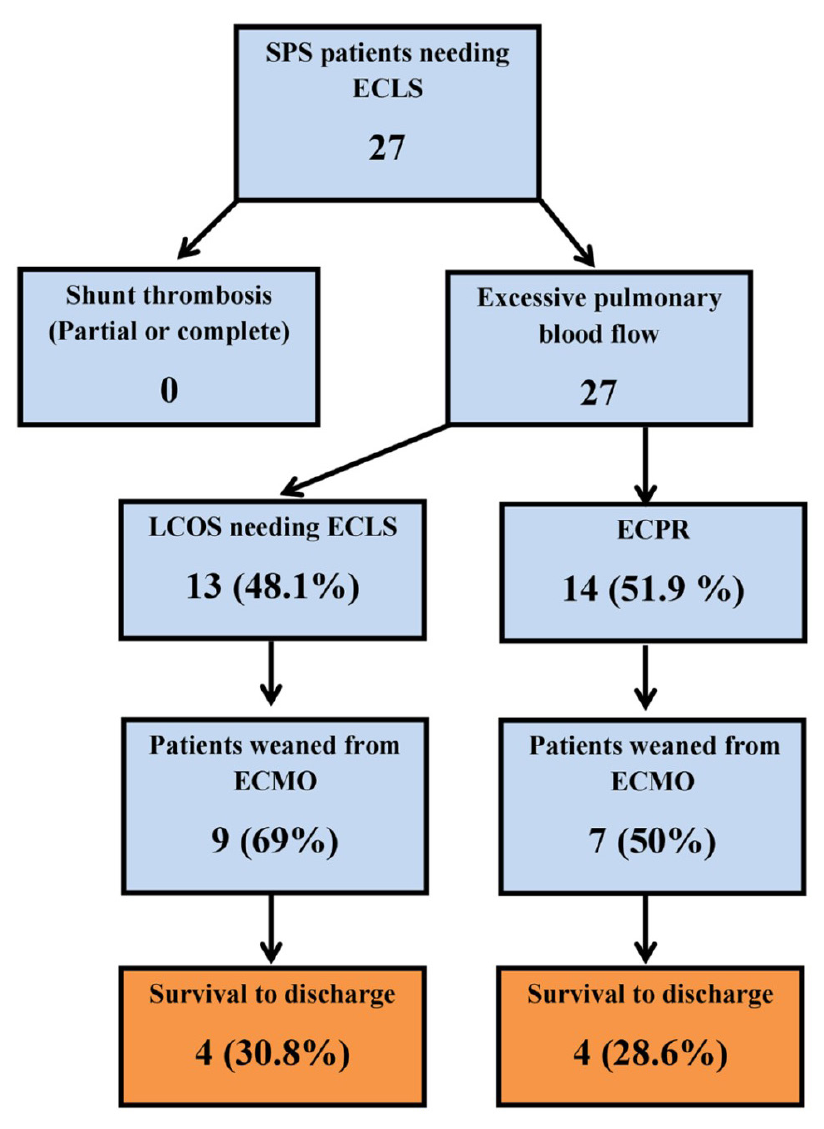
Fig. 2 - Patients’ characteristics. Out of 27 systemic to pulmonary artery shunt (SPS) patients needing extracorporeal life support (ECLS), 16 (59.3 %) patients survived ECLS weaning, and eight (29.6%) patients survived to discharge. ECMO=extracorporeal membrane oxygenation; ECPR=extracorporeal cardiopulmonary resuscitation; LCOS=low cardiac output